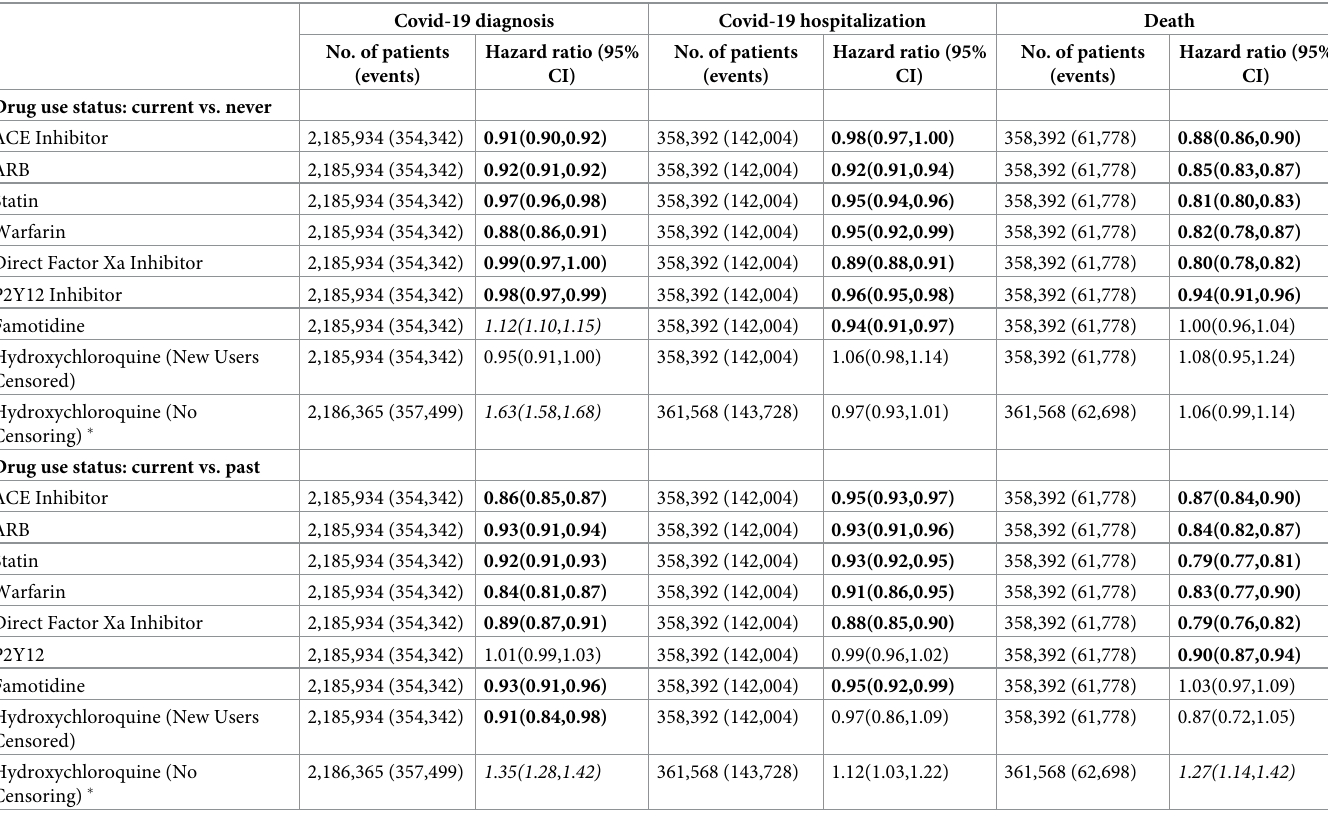
Table 3. Effect of drug use on Covid-19 diagnosis, Covid-19 hospitalization and death (other non-drug covariates are listed in Table